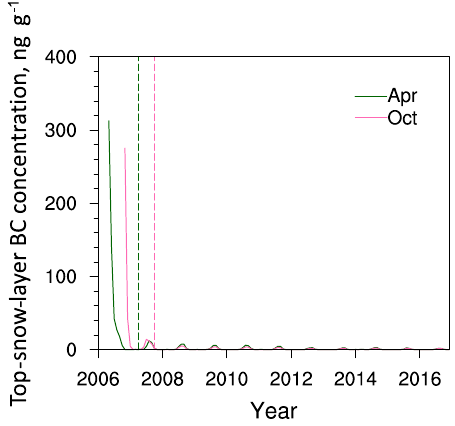
Figure 3. Temporal evolution of hydrophilic BC concentration in the top snow layer averaged over the Greenland region from two 11-year (2006–2016) simulations with wet BC deposition occur- ring in April and October of the first year. The BC concentration in precipitation is the maximum value shown in Fig. 1. Dashed lines represent the ends of 1 year since different deposition